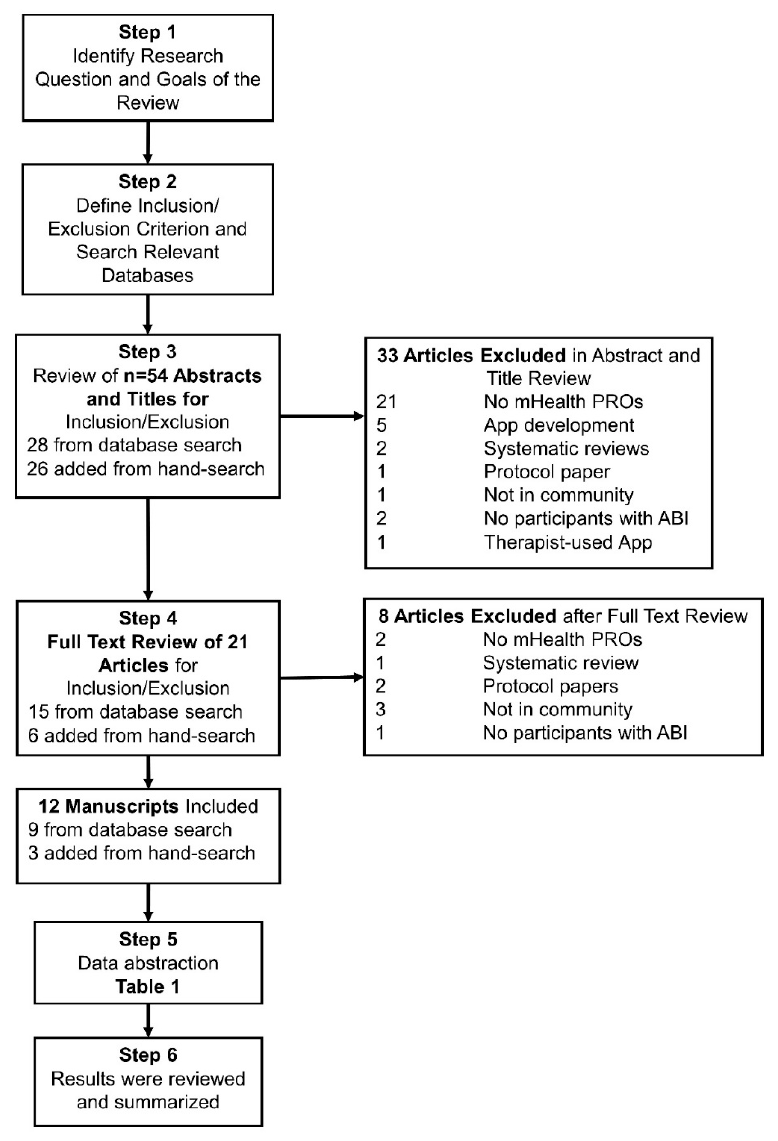
Figure 1. Flow chart of study inclusion and exclusion.